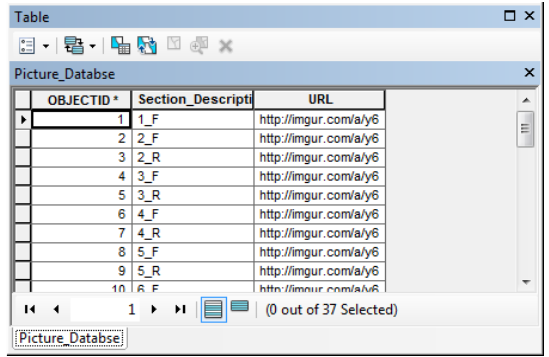
Figure 14: Reduced seat attribute